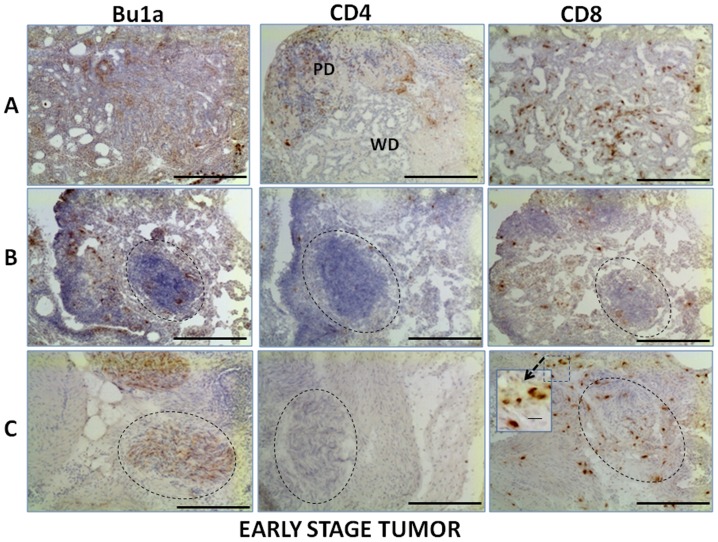
Localization of immune cells in early stage ovarian tumors.Bu1a+, CD4+ and CD8+ cells are shown in similar regions of serial sections that contain tumor foci. More CD8+ T cells and B cells are present in tumor foci than CD4+ T cells. (A) Early-stage tumor showing CD4+ cells in a tumor with poorly differentiated (PD) structure, and CD8+ and B cells in an adjacent well differentiated (WD) area. (B) A small lesion (dotted circle) containing CD8+ T cells and Bu1a+ cells, but not CD4+ cells. (C) An area with neoplastic cells containing CD8+ and Bu1a+ cells, but not CD4+ cells. Original magnification, 10x; scale bar = 100 µm. Stained CD8+ lymphocytes in a selected area (dotted box) is shown in an inset at higher magnification; scale bar = 10 µm.